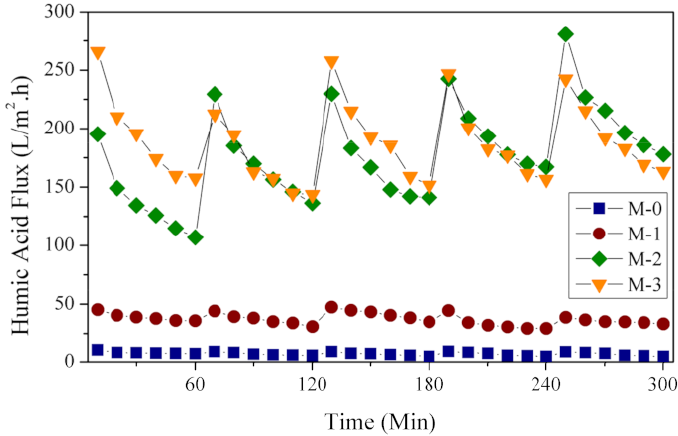
Figure 7. Reduction and recovery of humic acid flux during five filtration